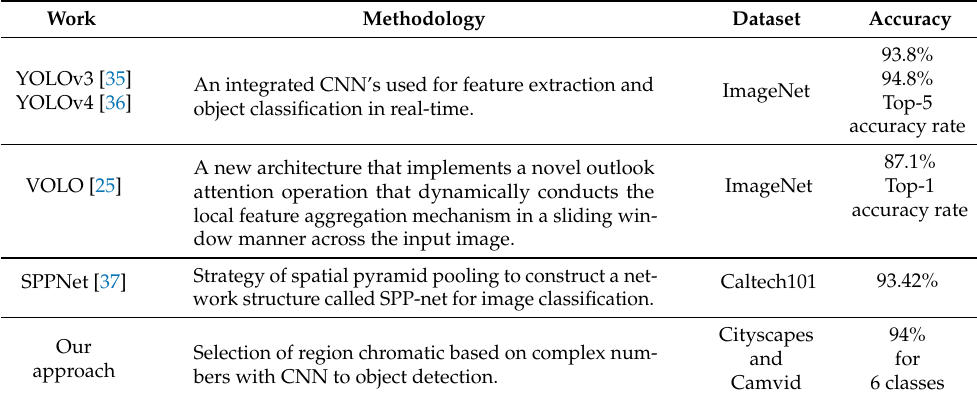
Table 7. Comparison with related